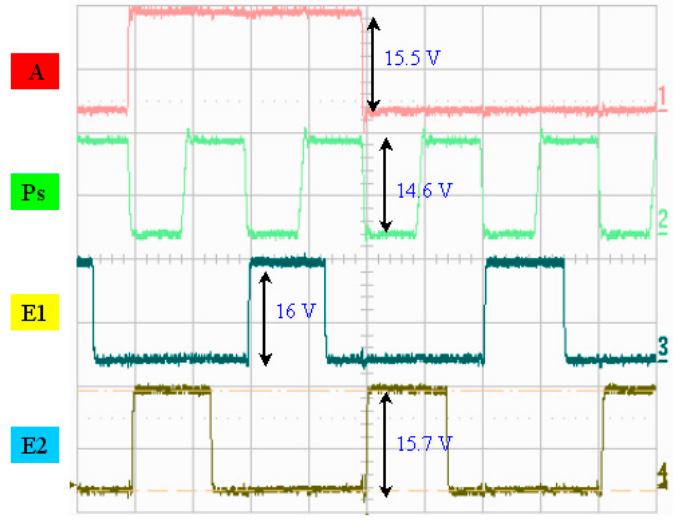
Figure 9. Voltage-scale testing.